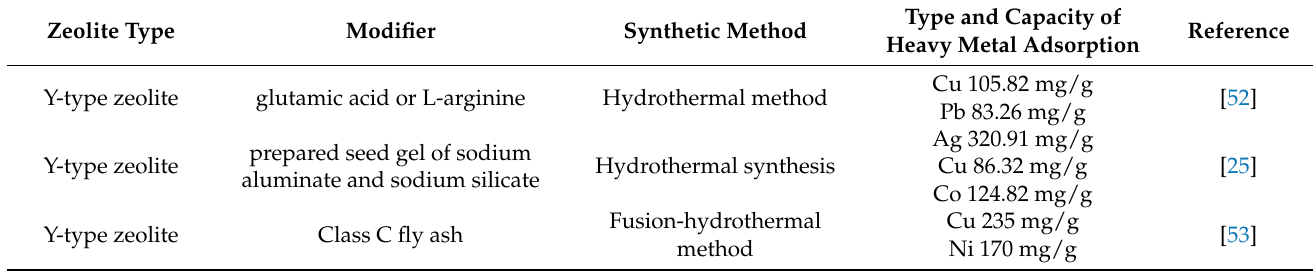
Table 6. Comparison of adsorption capacity of zeolite adsorbent for Cu(II) and Pb(II)